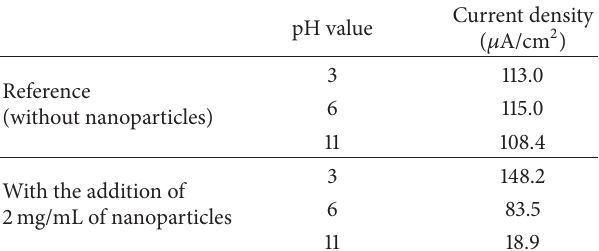
Table 2: Calculated current density values obtained from the experimental polarization curves.